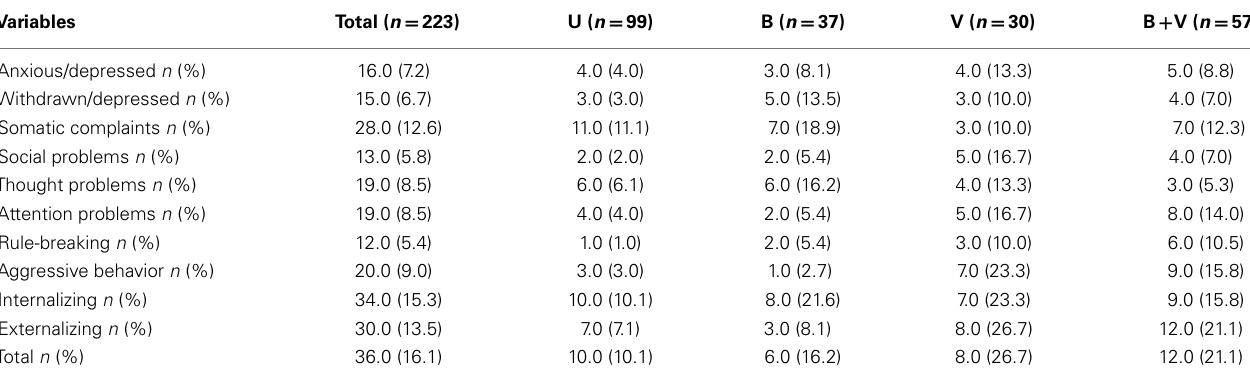
Table 2 | Prevalence of psychosocial and behavioral problems classified by CBCL.